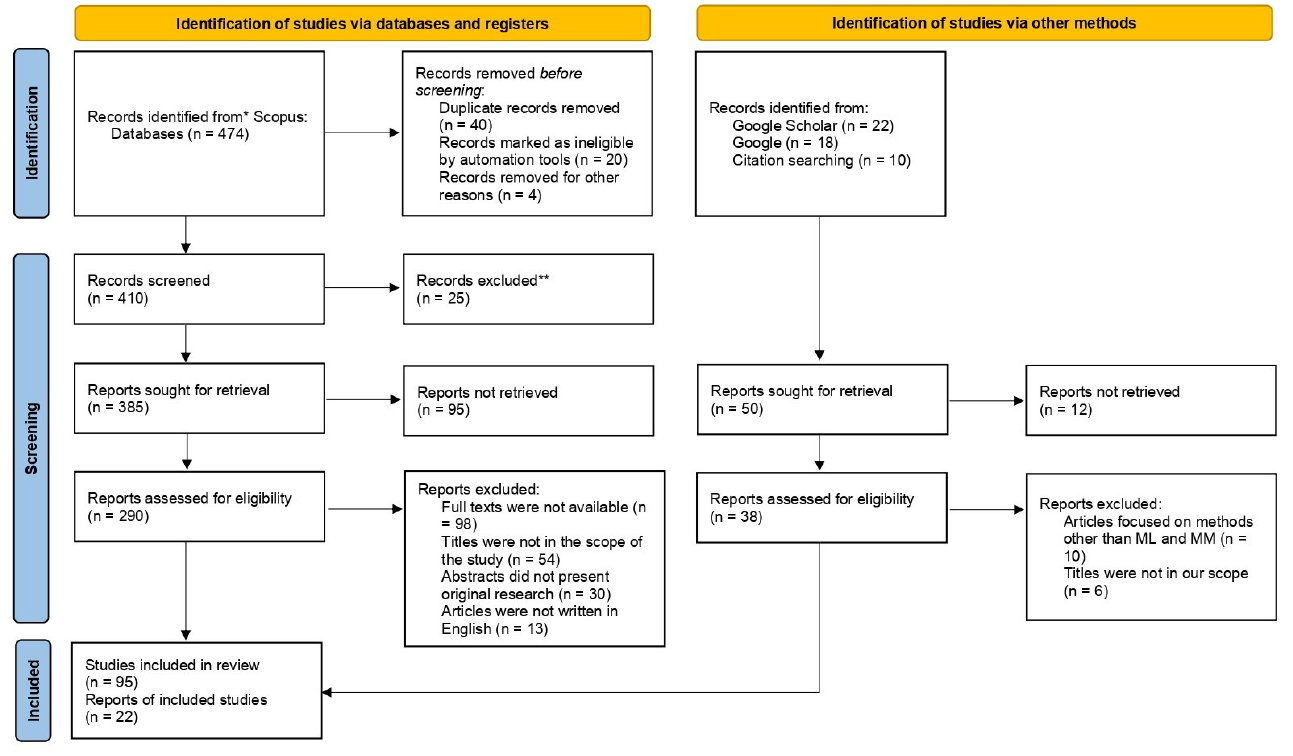
Figure 3. The PRISMA diagram for inclusion and exclusion criteria of literature. * means all the records were from Scopus, whiles ** means the records were discarded in its entirety.